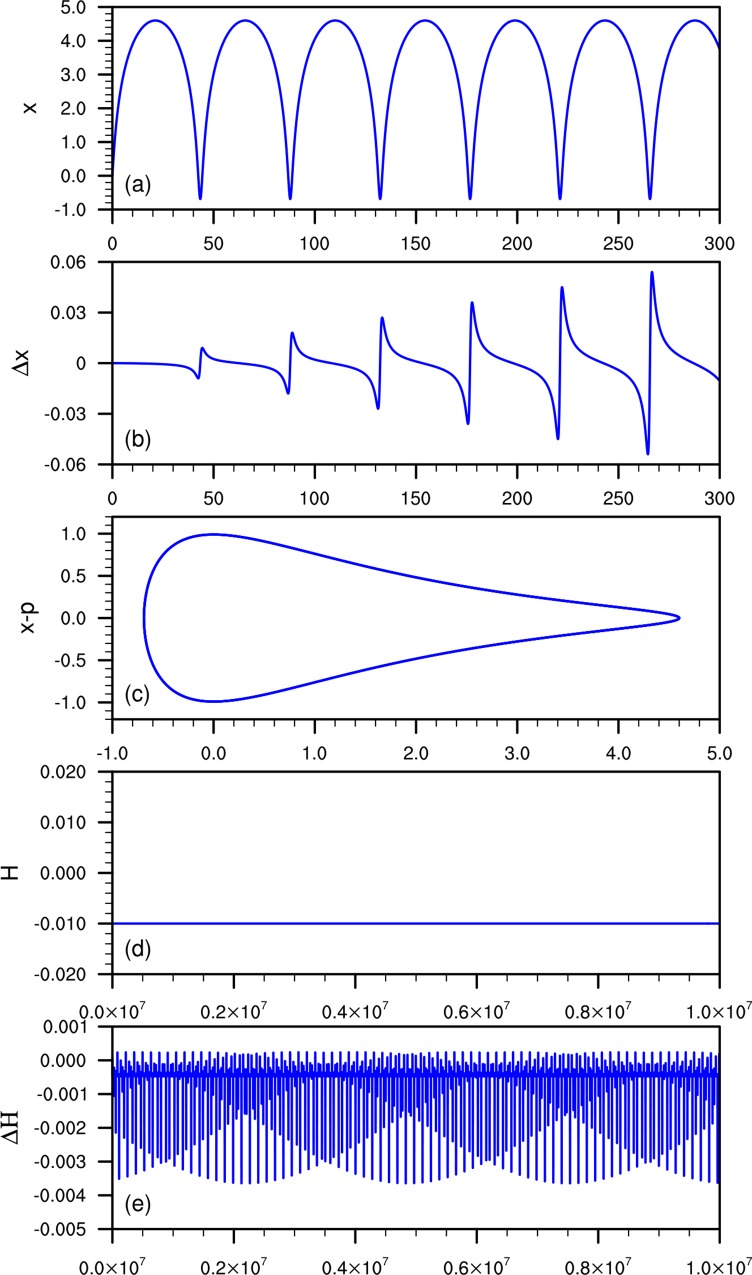
Illustrations of the direct simulation of Eq 2: (a) variable x by PMT; (b) error of x computed by the SE2 method; (c) structure of the x-p plane by PMT; (d) the Hamiltonian H by PMT to T = 107; (e) error of the Hamiltonian H by the SE2 method. Panels (a–c) have step-size h = 0.01; (d–e) have step-size h = 0.1.